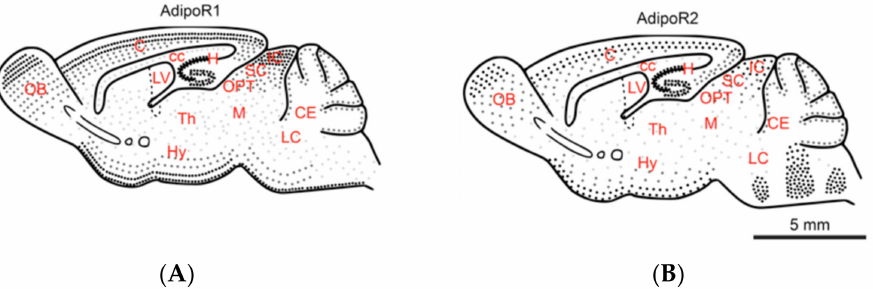
Figure 1. Schematic representation of AdipoR1 and AdipoR2 distribution on a sagittal mouse brain section. ( A ) AdipoR1 and ( B ) AdipoR2 are widely expressed throughout the main brain subdivisions and display overlapping patterns. Each black dot represents AdipoR1 ( A ) and AdipoR2 ( B )